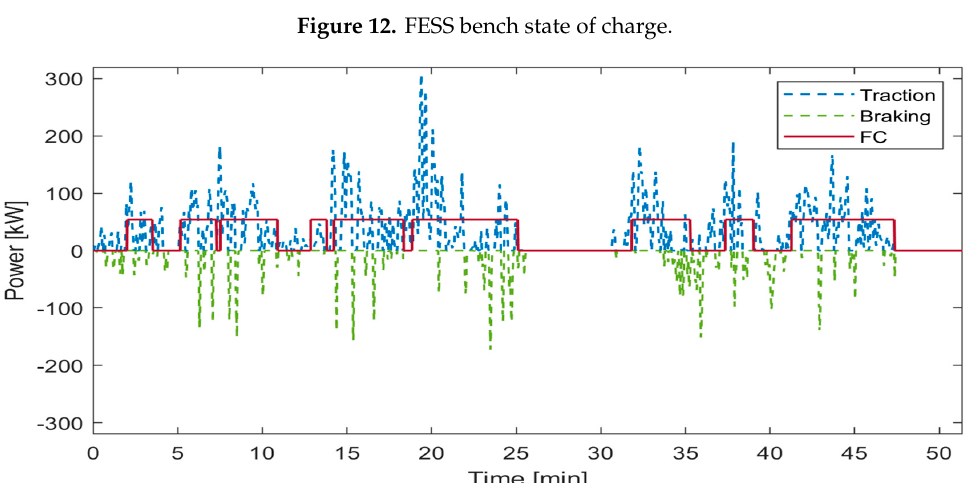
Figure 13. Electric power profiles: traction (blue), regenerative braking (green), and FC (red).